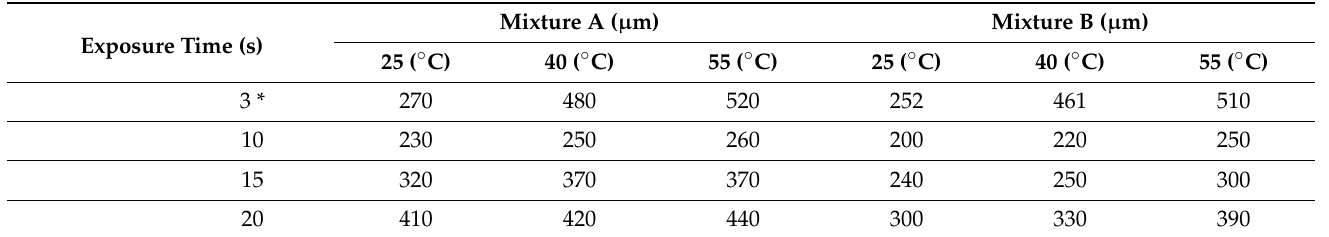
Table 3. The depth of the cure measurement ( µ m) of Mixtures A and B at different temperatures.